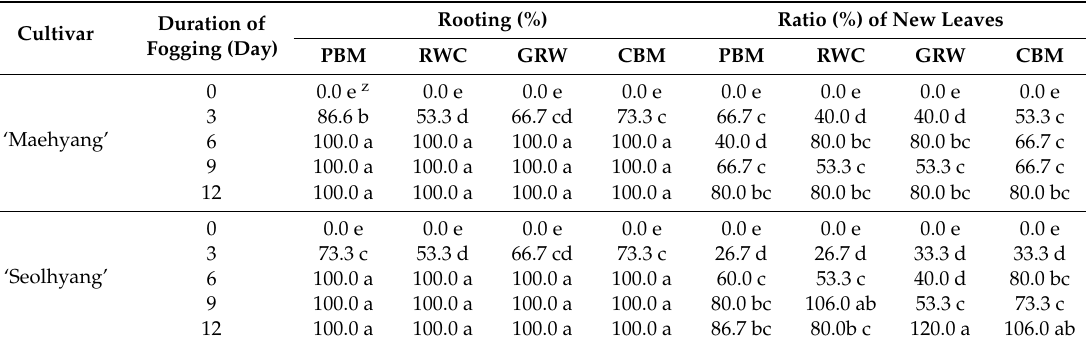
Figure 5. The e ff ects of the growth medium on the survival percentage of daughter plants of strawberry ‘Seolhyang’ in the 0, 3, 6, 9 and 12 days fogging treatments. Error bars represent the SEs of the three observation units ( n = 3). PBM, a peat moss-based mixture; RWC, rockwool cube; GRW, granular rockwool; and CBM, a coir-based mixture. Table 2. The percentages of rooting and ratio of new leaves of strawberry runners a ff ected by the fogging duration, medium and cultivar. The experiment was carried out in a glasshouse at GNU (35 ◦ 09 (cid:48) N, 128 ◦ 05 (cid:48) E) on 14–27 September